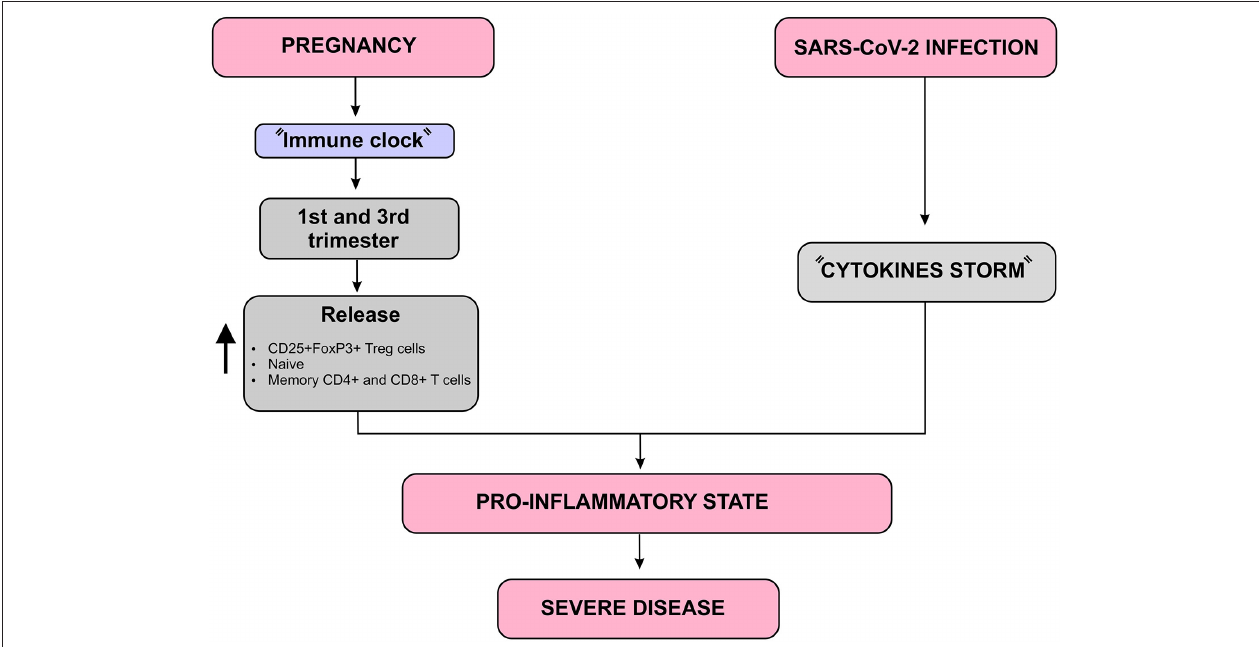
FIGURE 6 | Immunological complications that may worsen the SARS-CoV-2 infection prognosis in pregnant women diagram. In addition to the “Cytokines storm” induced by SARS-CoV-2, there is a natural increase in pro-inflammatory mediators such as CD25 + FoxP3 + Treg cells, naive and memory CD4 + and CD8 + T cells during the first and third trimesters of pregnancy, which is known as “Immune clock.” These two aspects together lead to a more severe pro-inflammatory state which may worsen the SARS-CoV-2 infection, especially during the first and third trimesters of